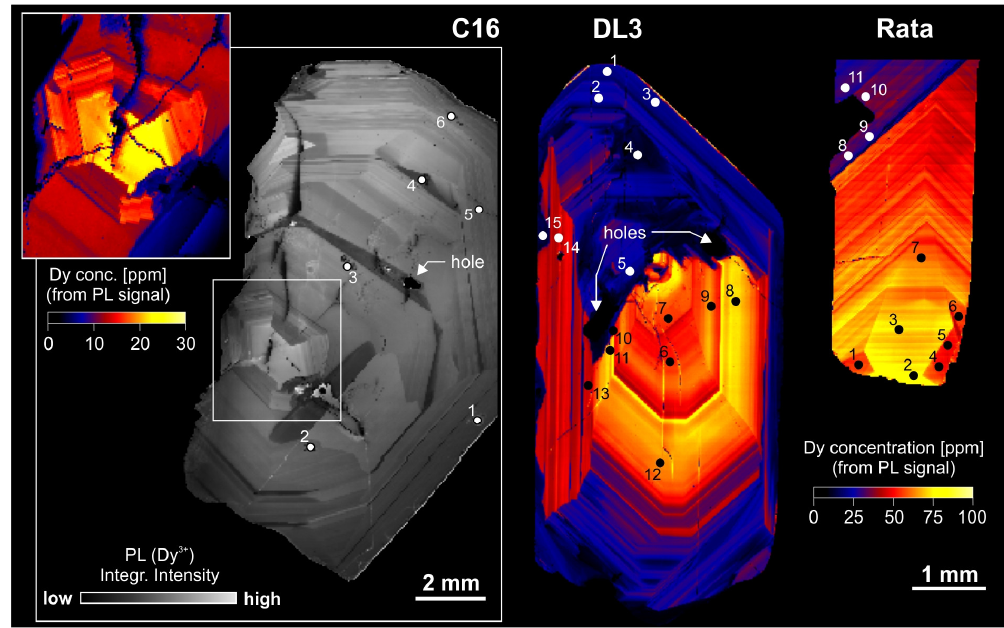
Figure 5. Laser-induced photoluminescence hyperspectral images of zircon samples from the Central Highlands (C16 and DL3) and from Ratanakiri, Cambodia (Rata). The integrated intensity of the Dy 3+ ( 4 F 9/2 → 6 H 13/2 ) emission (compare Figure 6) is the plotted spectral parameter